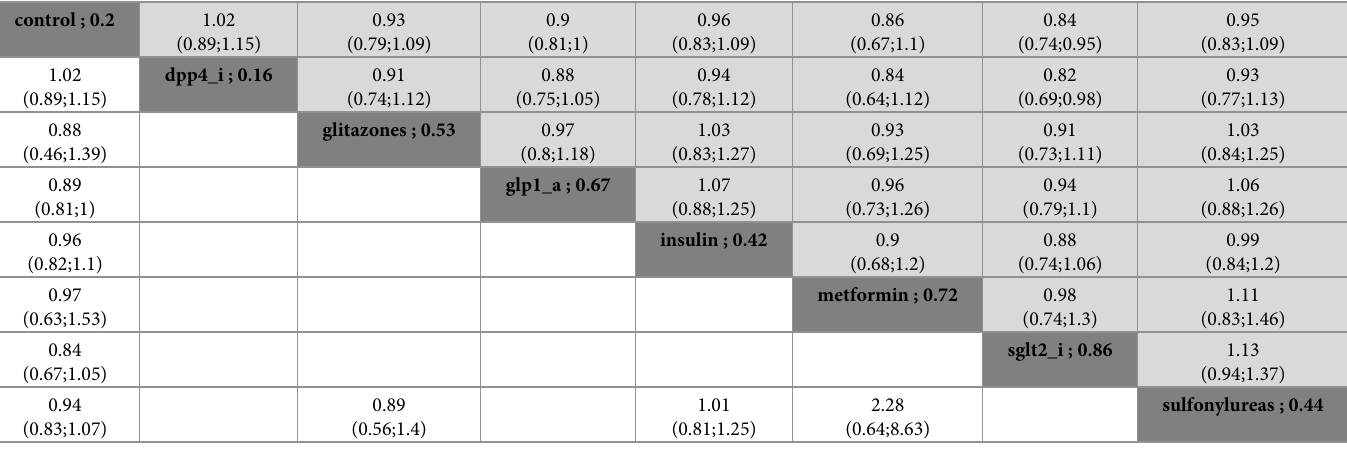
Cardiovascular mortality. Twenty-seven studies contributed to the analysis for cardio- vascular mortality, including 6,221 cardiovascular deaths. Each active drug class had direct comparisons against control. The comparison network and forest plots of the direct compari- sons are shown in supplementary S3B Fig_Network, S3B Fig_DPP-4_I VERSUS CONTROL, S3B Fig_GLITAZONES VERSUS CONTROL, S3B Fig_GLP-1_A VERSUS CONTROL, S3B Fig_INSULIN VERSUS CONTROL, S3B Fig_METFORMIN VERSUS CONTROL, S3B Fig_SGLT-2_I VERSUS CONTROL, S3B Fig_SULFONYLUREA VERSUS CONTROL, S3B Fig_SULFONYLUREA VERSUS GLITAZONES, S3B Fig_INSULIN VERSUS SULFONYL- UREA, S3B Fig_METFORMIN VERSUS SULFONYLUREA. No significant differences were observed in the network comparisons. SUCRA values suggested SGLT-2 inhibitors have the Table 2. Treatment effect estimates for overall